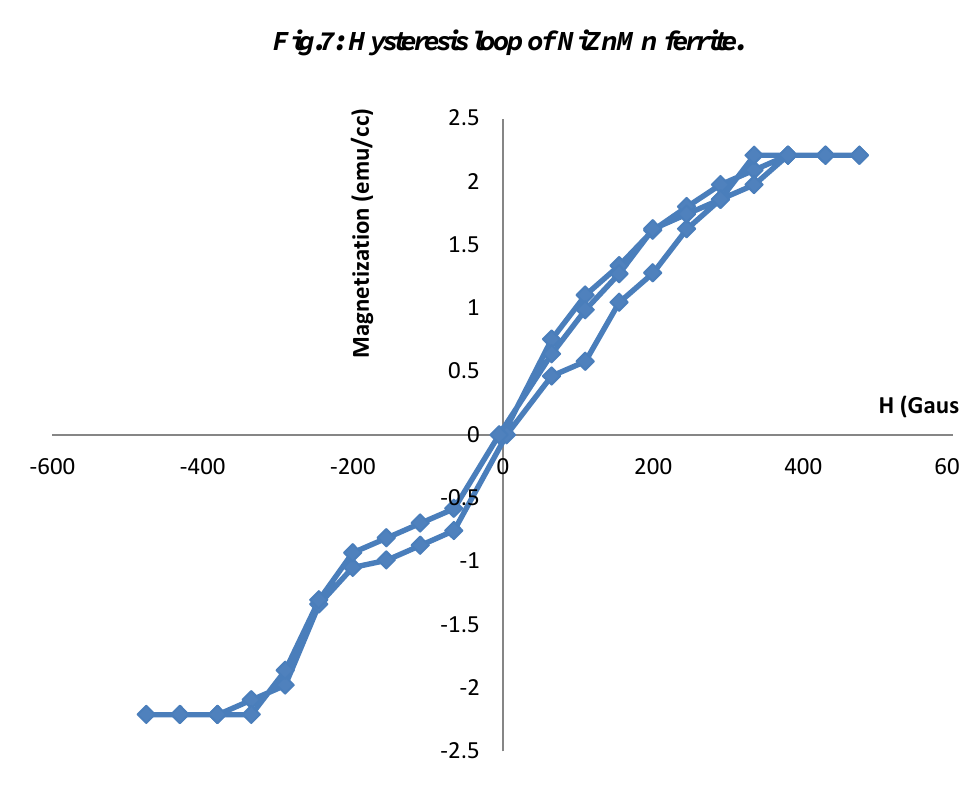
Fig.8: Hysteresis loop of Ni